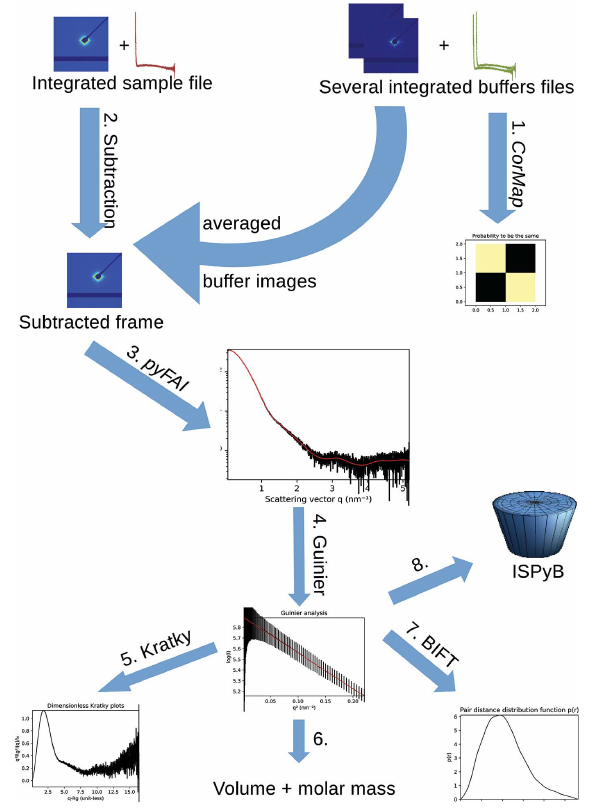
Figure 6 Schematic of the sample-changer pipline: 1, comparison of buffer curves; 2, subtraction of averaged buffer images from sample image; 3, azimuthal integration of the background-subtracted image; 4–7, SAS analysis (contains Guinier fit, Kratky plot and BIFT analysis); 8, registration into ISPyB.